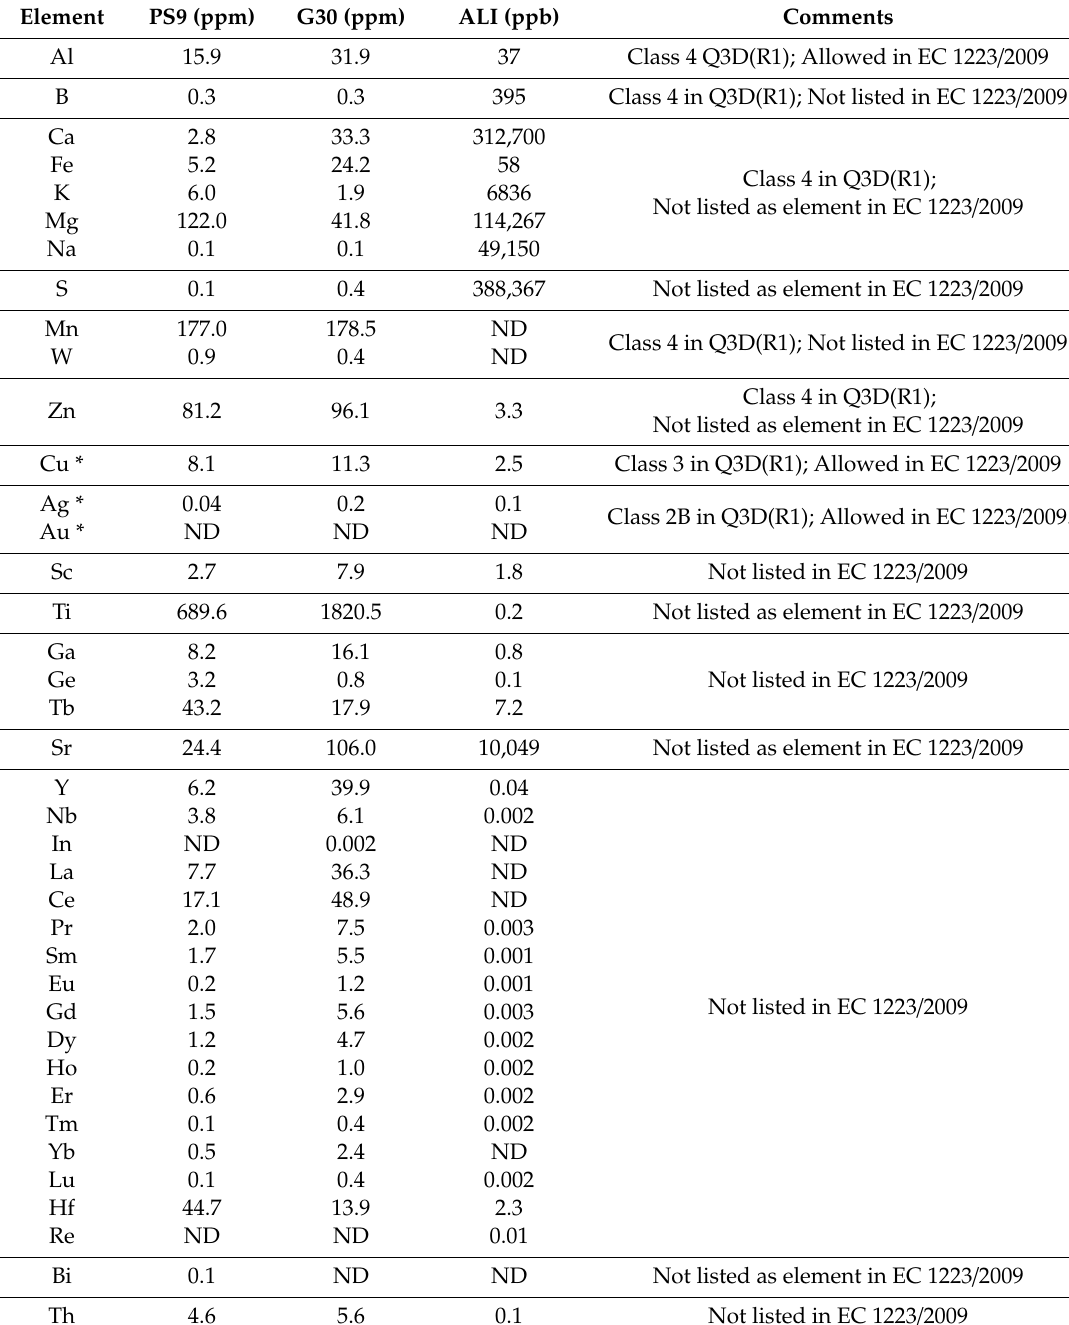
Table 1. Elemental composition of pristine samples (PS9, G30 and ALI) determined by ICP-OES and ICP-MS. “ND” stands for “Not Detected”. For a better understanding, comments about each element are included within the table. Levels of elements marked with * were obtained from [36].